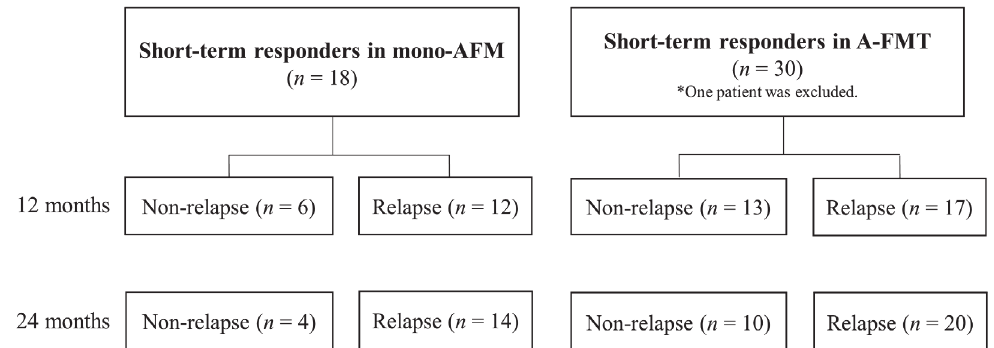
Figure 3. Flow diagram for long-term evaluation of patients who showed effects at 4 weeks after treatment. In the A-FMT (fresh fecal microbiota transplantation (FMT) following triple antibiotic therapy ( amoxicillin, fosfomycin, and metronidazole)) group, 13 patients did not experience relapse within 12 months, and 10 patients did not experience relapse within 24 months after receiving A-FMT. In the mono-AFM (triple antibiotic therapy (amoxicillin, fosfomycin, and metronidazole)) group, 6 patients did not experience relapse within 12 months, and 4 patients did not experience relapse within 24 months after AFM administration. * One patient in the A-FMT group was excluded because of the detection of dysplasia.